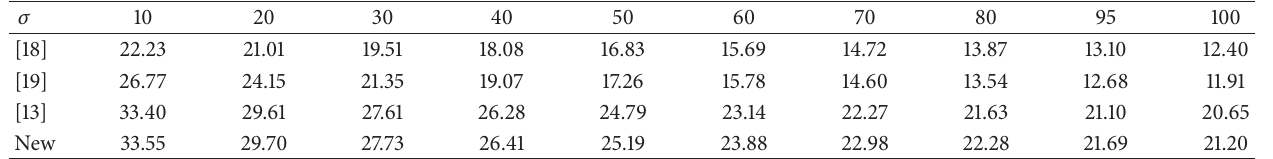
Table 5: PSNR of different algorithms with different Gaussian noise levels for Bus video sequence.